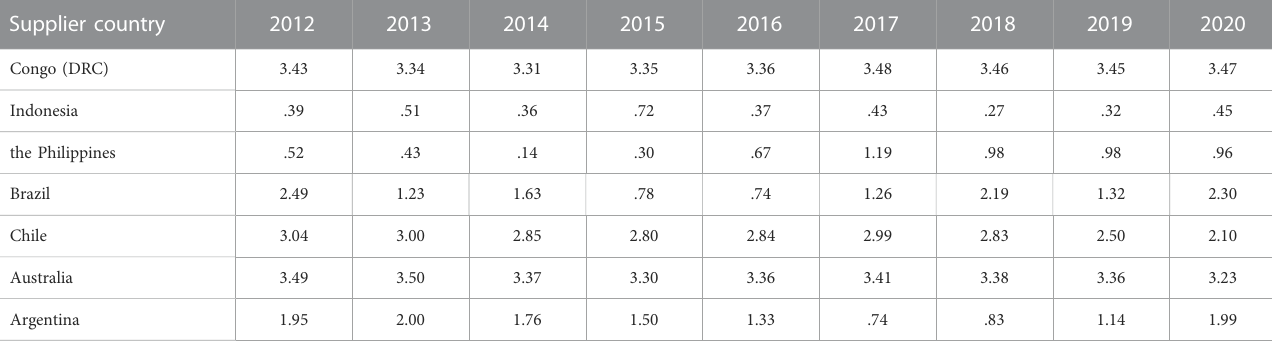
TABLE 6 Bilateral institutional distance between China and the source countries of lithium, cobalt, and nickel imports. Supplier